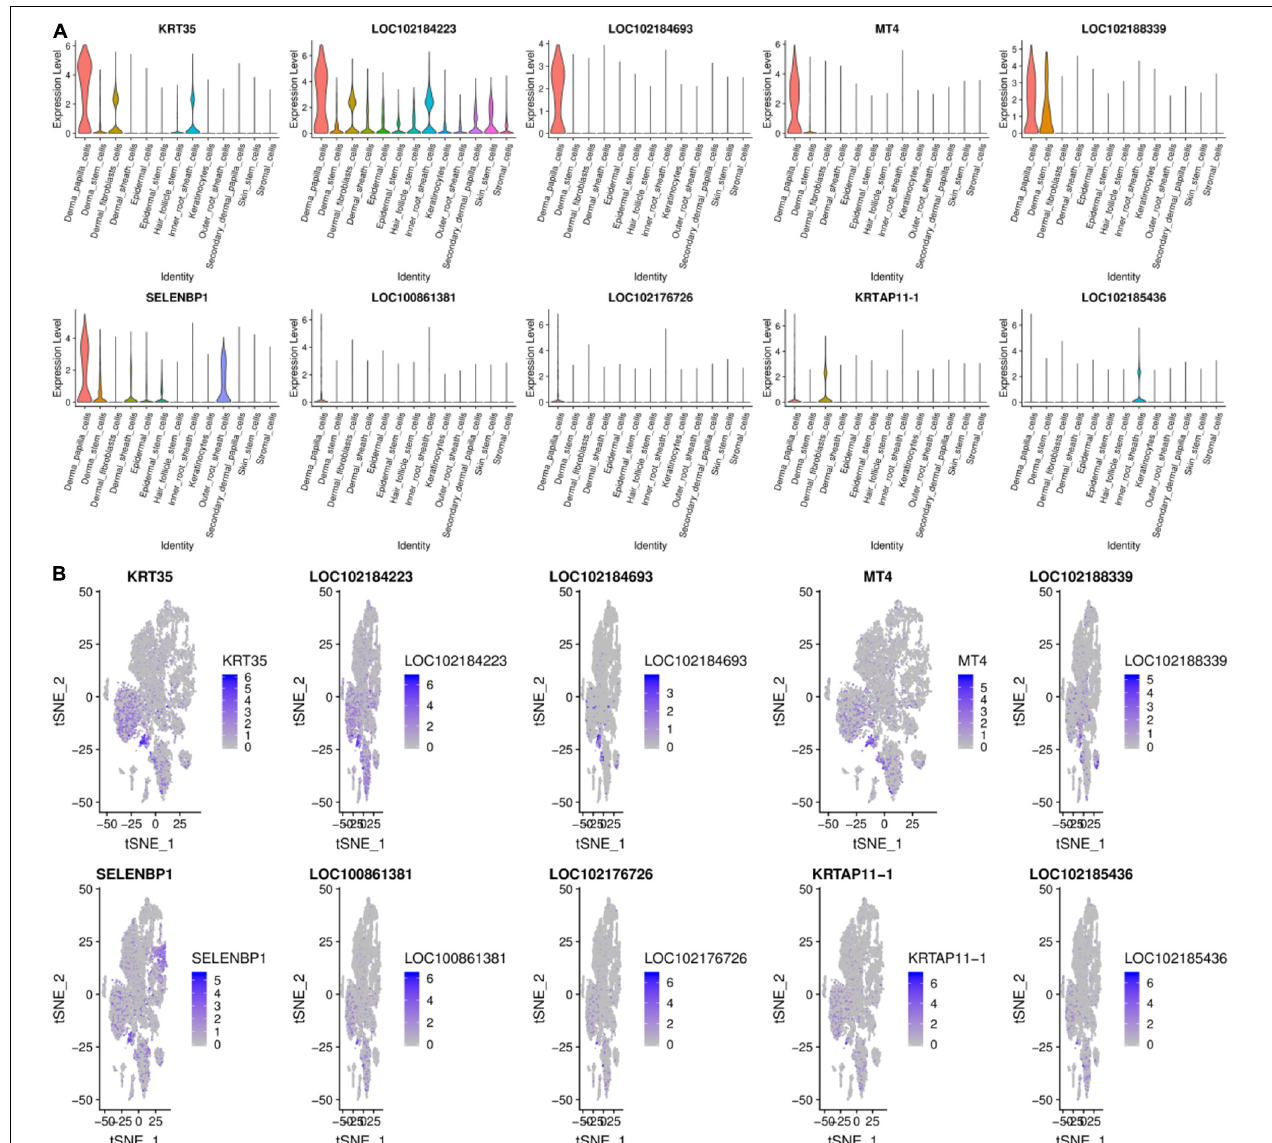
FIGURE 5 | Gene expression profiling of DPCs. (A) Violin plots for expression of top 10 genes. (B) Relative expression levels of top 10 genes on the t-SNE